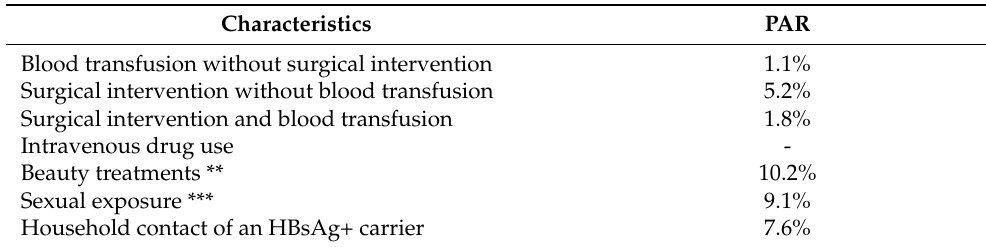
Table 5. Population attributable risk (PAR *) for risk factors in acute hepatitis B cases in Italy. SEIEVA